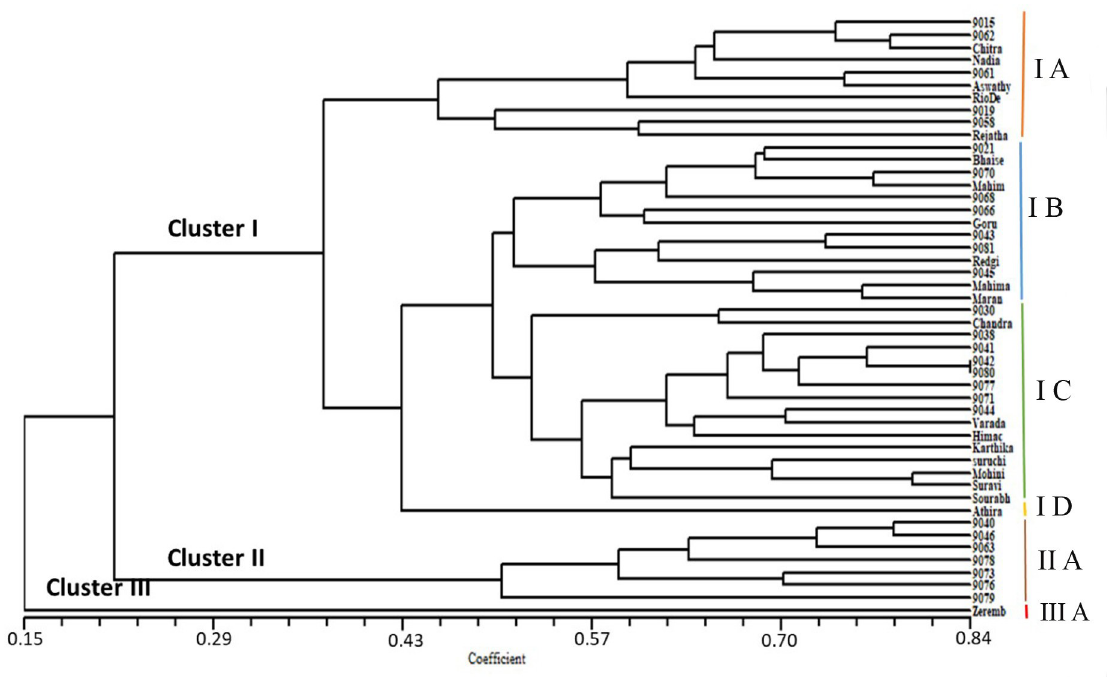
Fig 5. Genetic relationship of ginger accessions as revealed by SSR markers. Dendrogram of 48 ginger genotypes revealed by cluster analysis of genetic similarity estimates generated by Jaccard coefficient based on 12 EST-SSR markers.